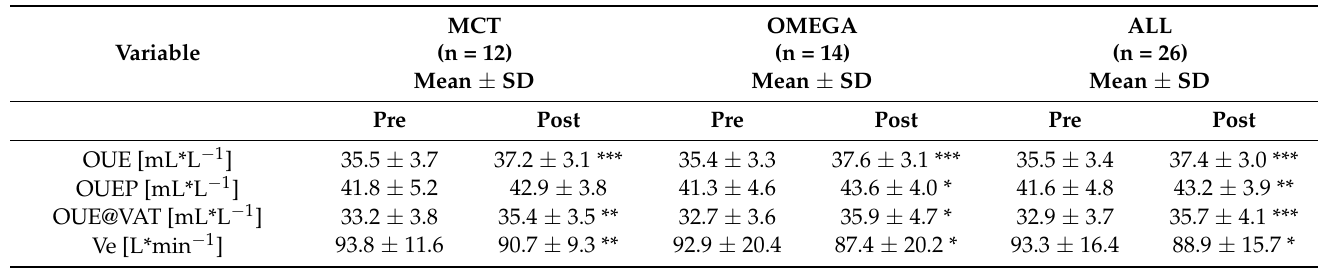
Table 2. Comparison of effects omega-3 fatty acid supplementation with placebo controlled on cardiorespiratory fitness (CRF)